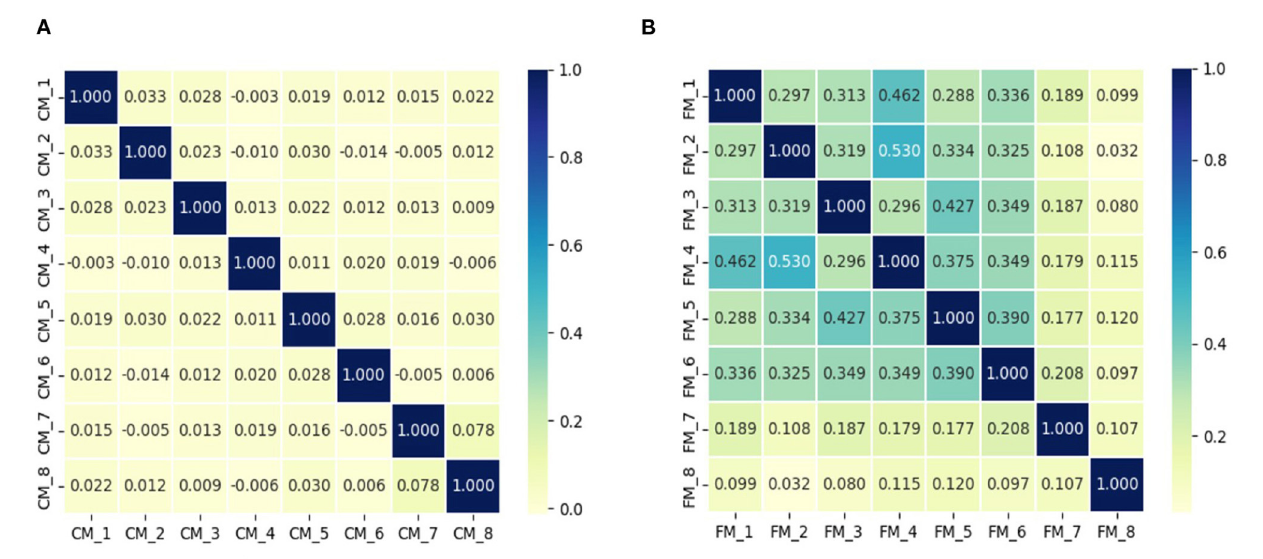
FIGURE2 The cosine similarity of the gradients of the sampled photos on the different models is depicted in the figure, where (A) is the visualization result of multiple classification models, and (B) is the visualization result of multiple deep facial recognition